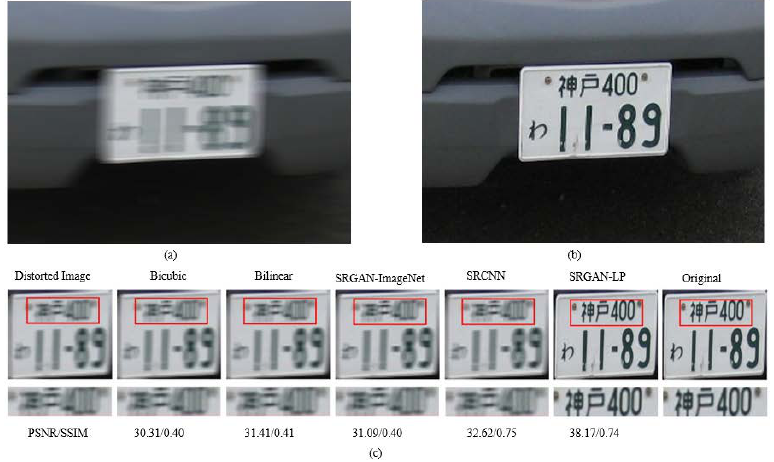
Figure 7. ( a ) Ground truth image (original image), ( b ) Motion blur applied on whole image (distorted image), ( c ) Visual quality of the reconstructed images along with the corresponding PSNR/SSIM